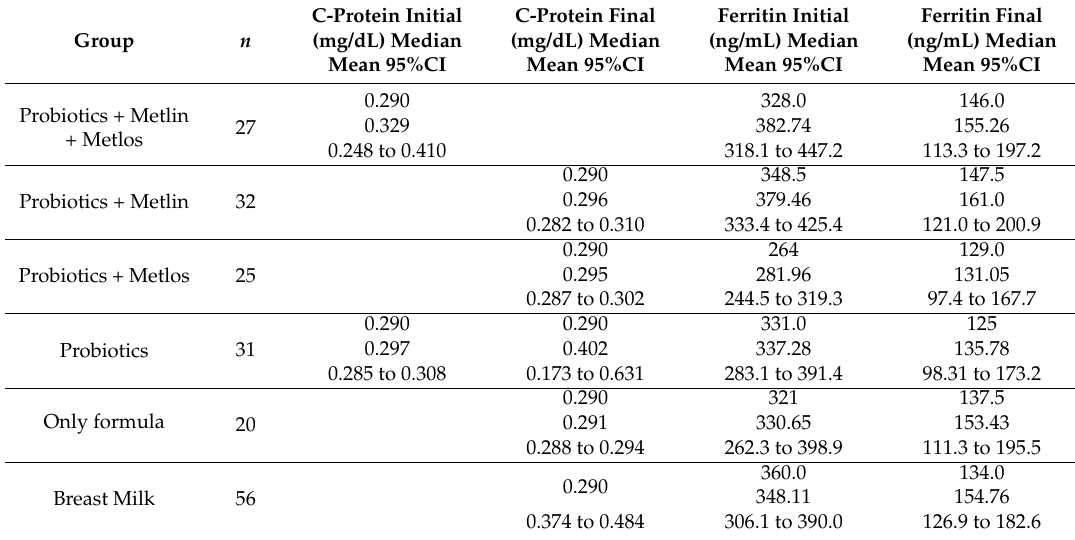
Table 3. Levels of C-reactive protein and serum